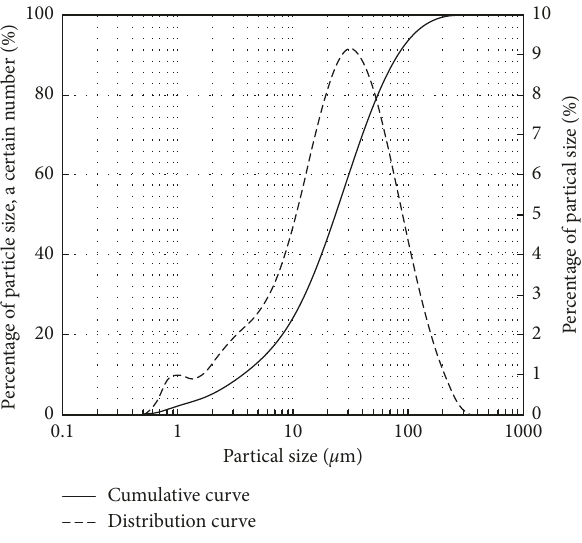
Figure 1: Particle size distribution of tested loess. Table 1: Some basic geotechnical properties of tested material.